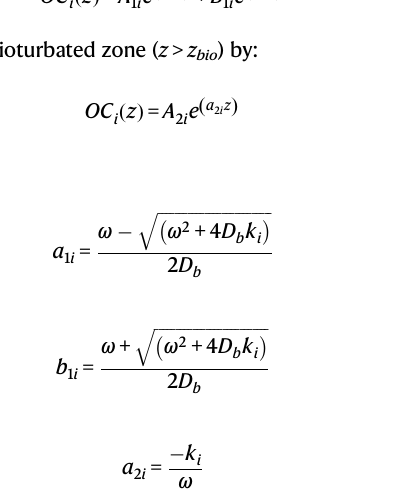
ffiffiffiffiffiffiffiffiffiffiffiffiffiffiffiffiffiffiffiffiffiffiffiffiffiffiffi (cid:6) ω 2 +4 D b k i